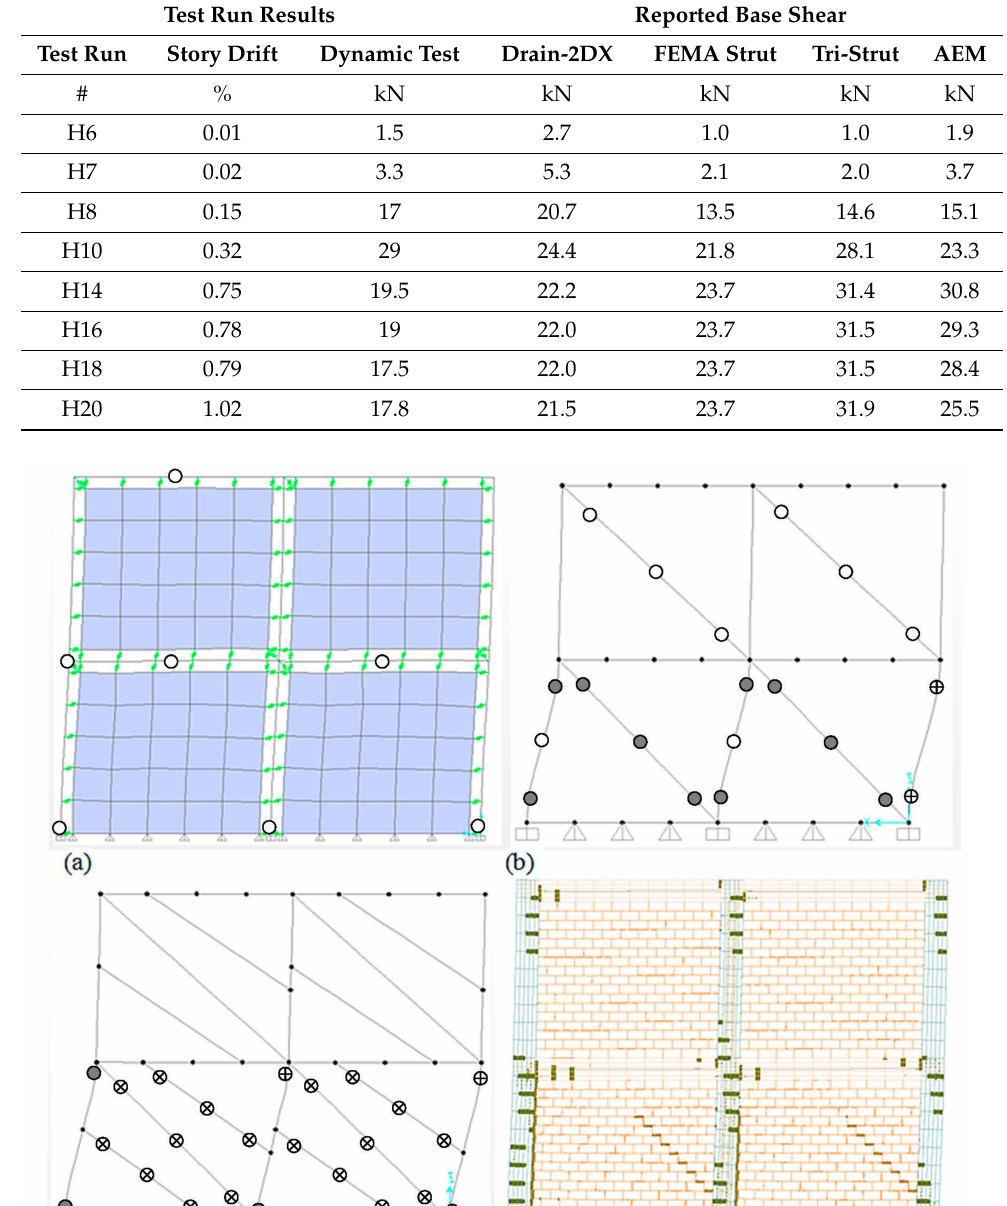
Table 2. Reported Base Shears from Pushover Curves for H-Building Structure.